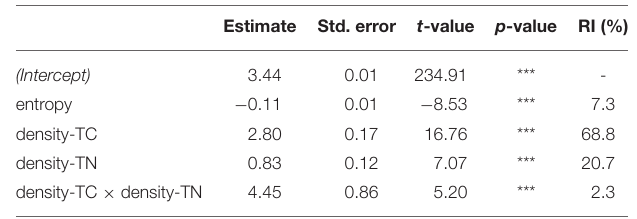
RI indicates the relative importance (normalised to 100%). The significance codes are all adjusted because of the 8 multi-comparisons.